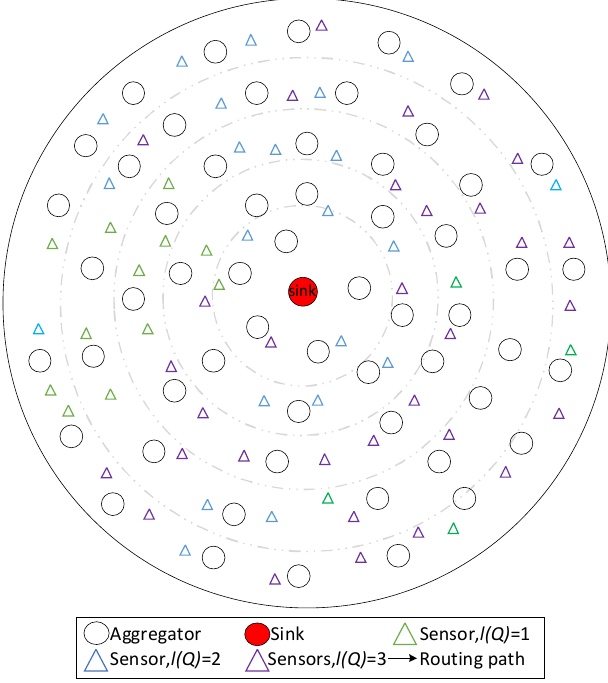
Figure 1. An instance of the system model.